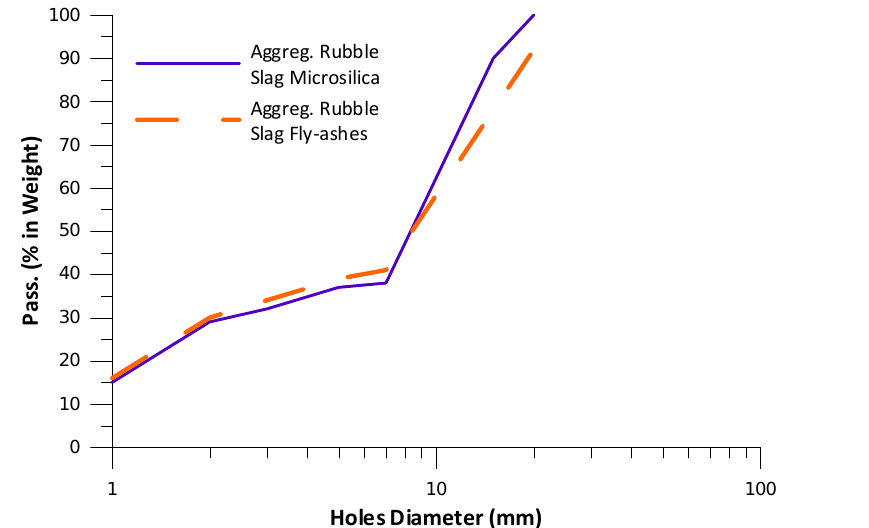
Figure 4. Granulometric curves of the aggregates of slag and FA concrete, and slag and SF concrete.